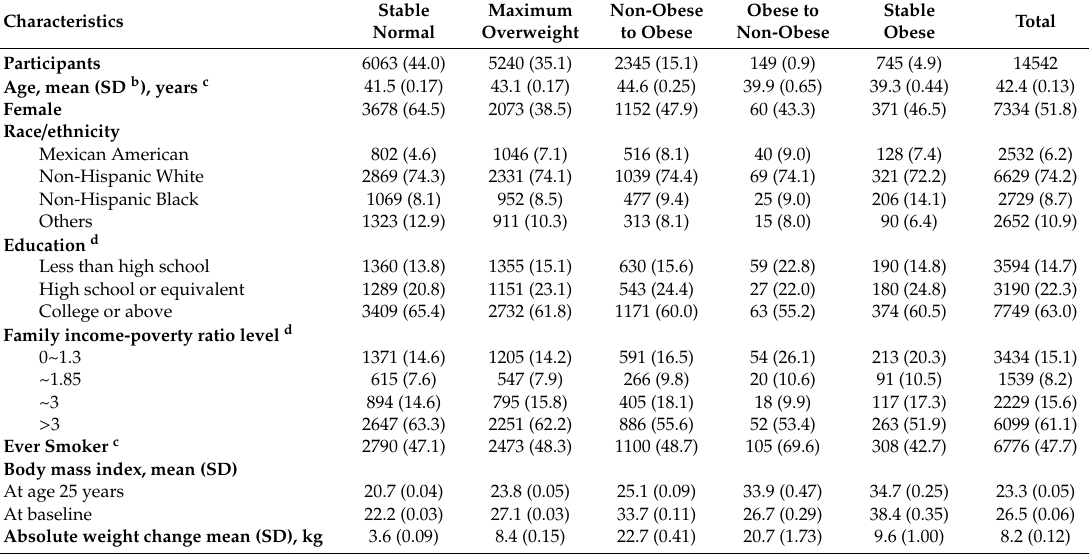
Table 1. Characteristics of the National Health and Nutrition Examination Survey (NHANES) study participants according to weight change patterns from early to middle adulthood, 1999–2016 a